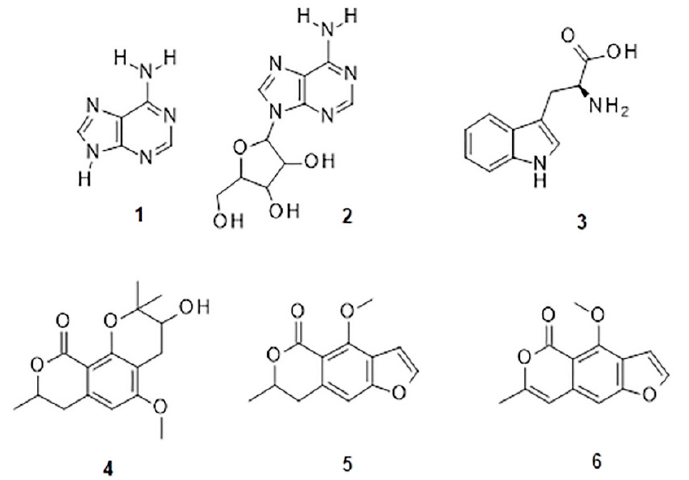
Figure 2. Chemical structures of major compounds identified from CSEE by mass spectrometry.